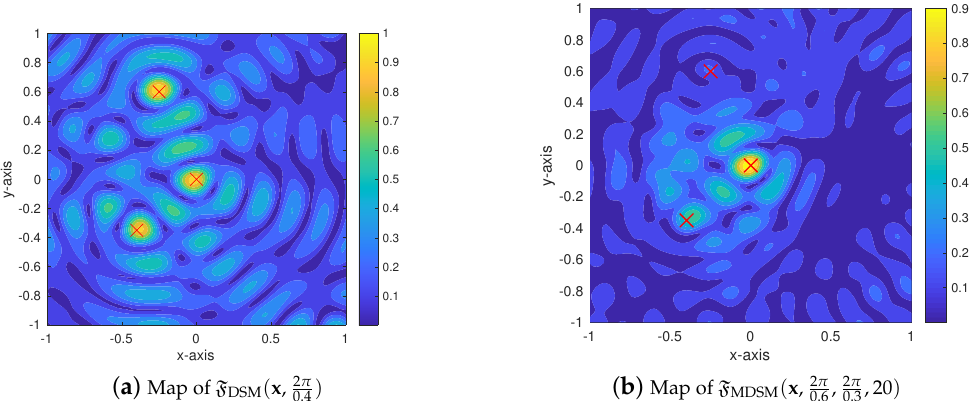
Figure 8. (Example 6) Simulation results with d = ( 0,1 ) . The red-colored marks × denote the locations of cracks.